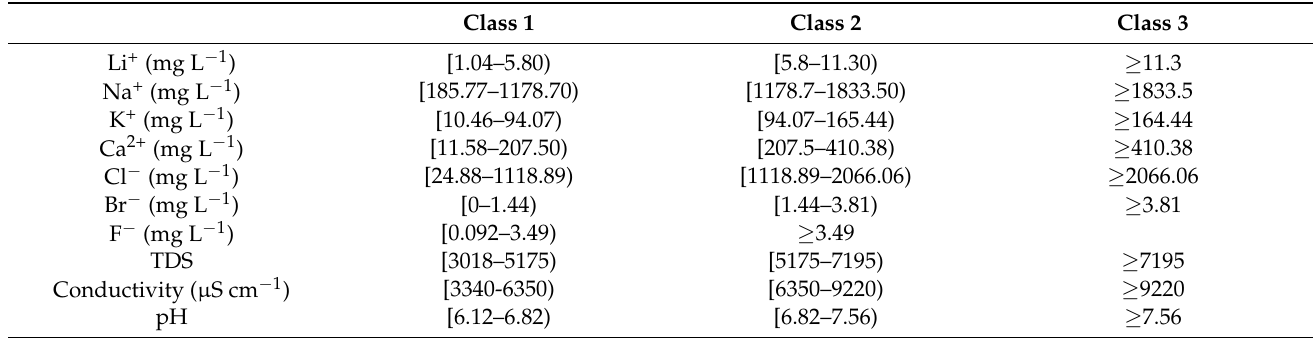
Table 4. Range of environmental variables for each class.